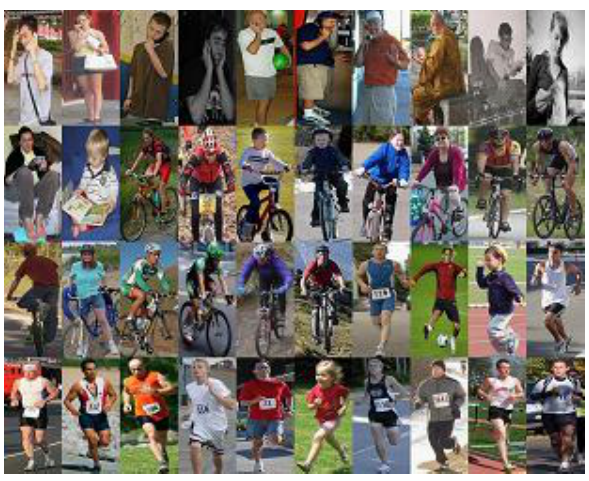
Figure 1. Human pose